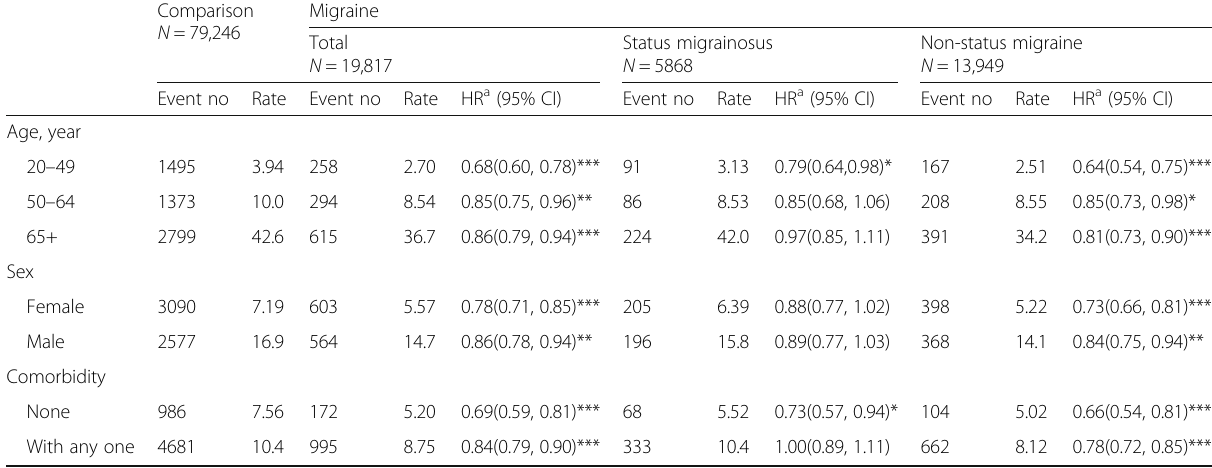
Table 3 Incidence and hazard ratios of mortality stratified by age, sex, and comorbidity for patients with migraine comparing with those without migraine